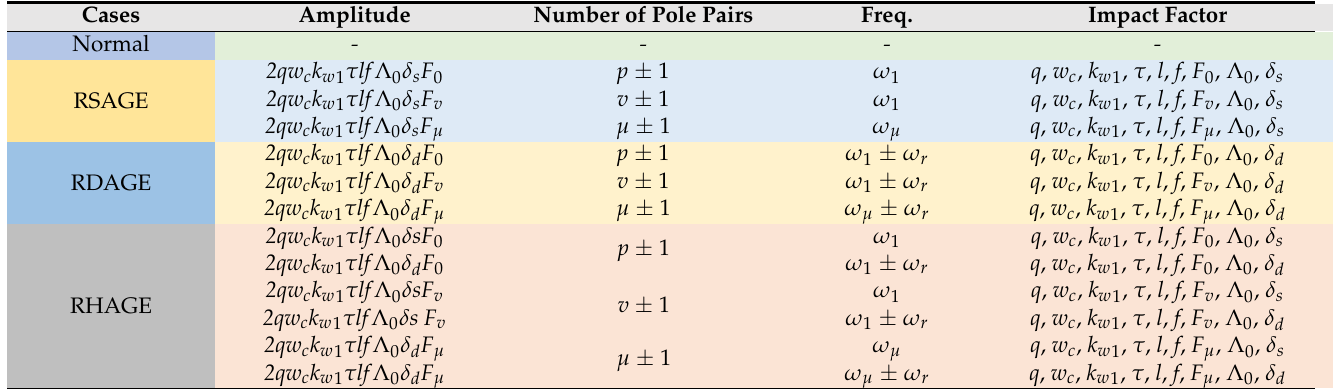
Table 2. Circulating current characteristics of stator parallel branches before and after eccentricity.